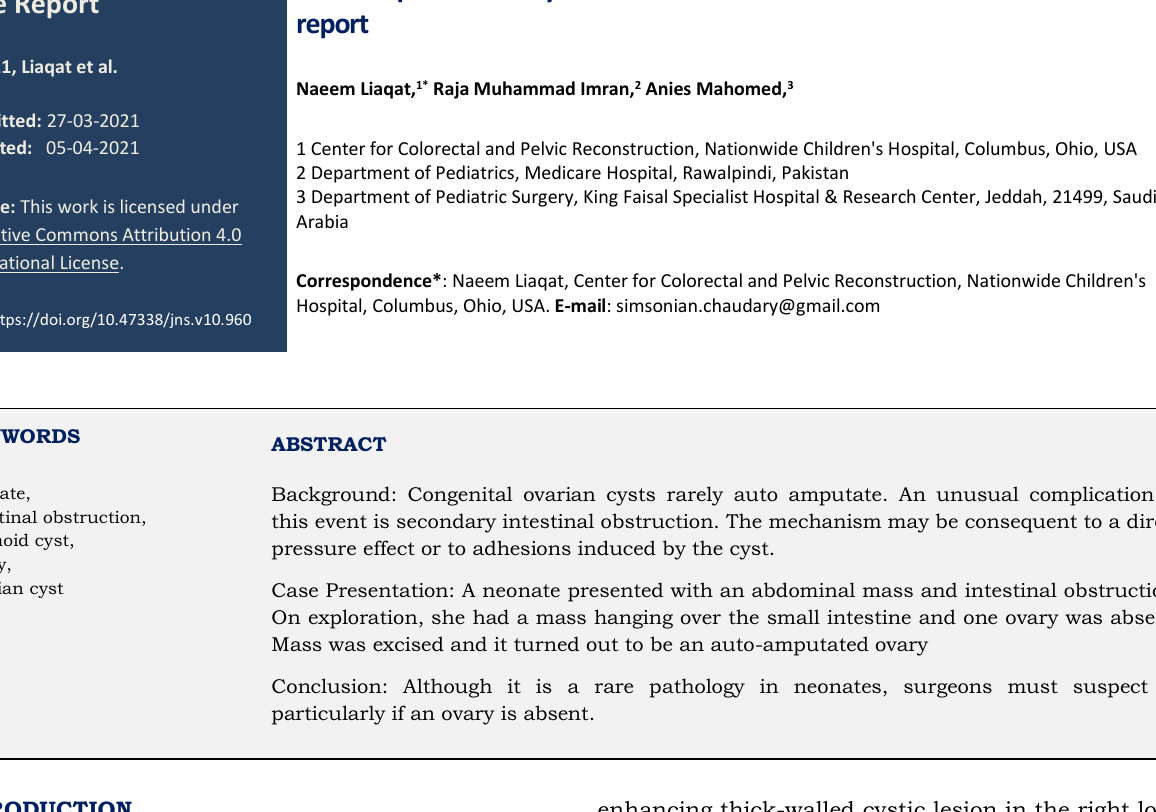
enhancing thick-walled cystic lesion in the right lower abdomen of unknown origin.